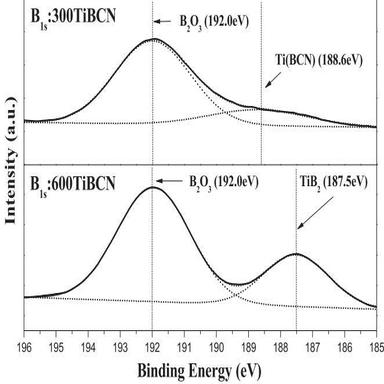
XPS spectra for the B1s region of the 300TiBCN and 600TiBCN specimens.